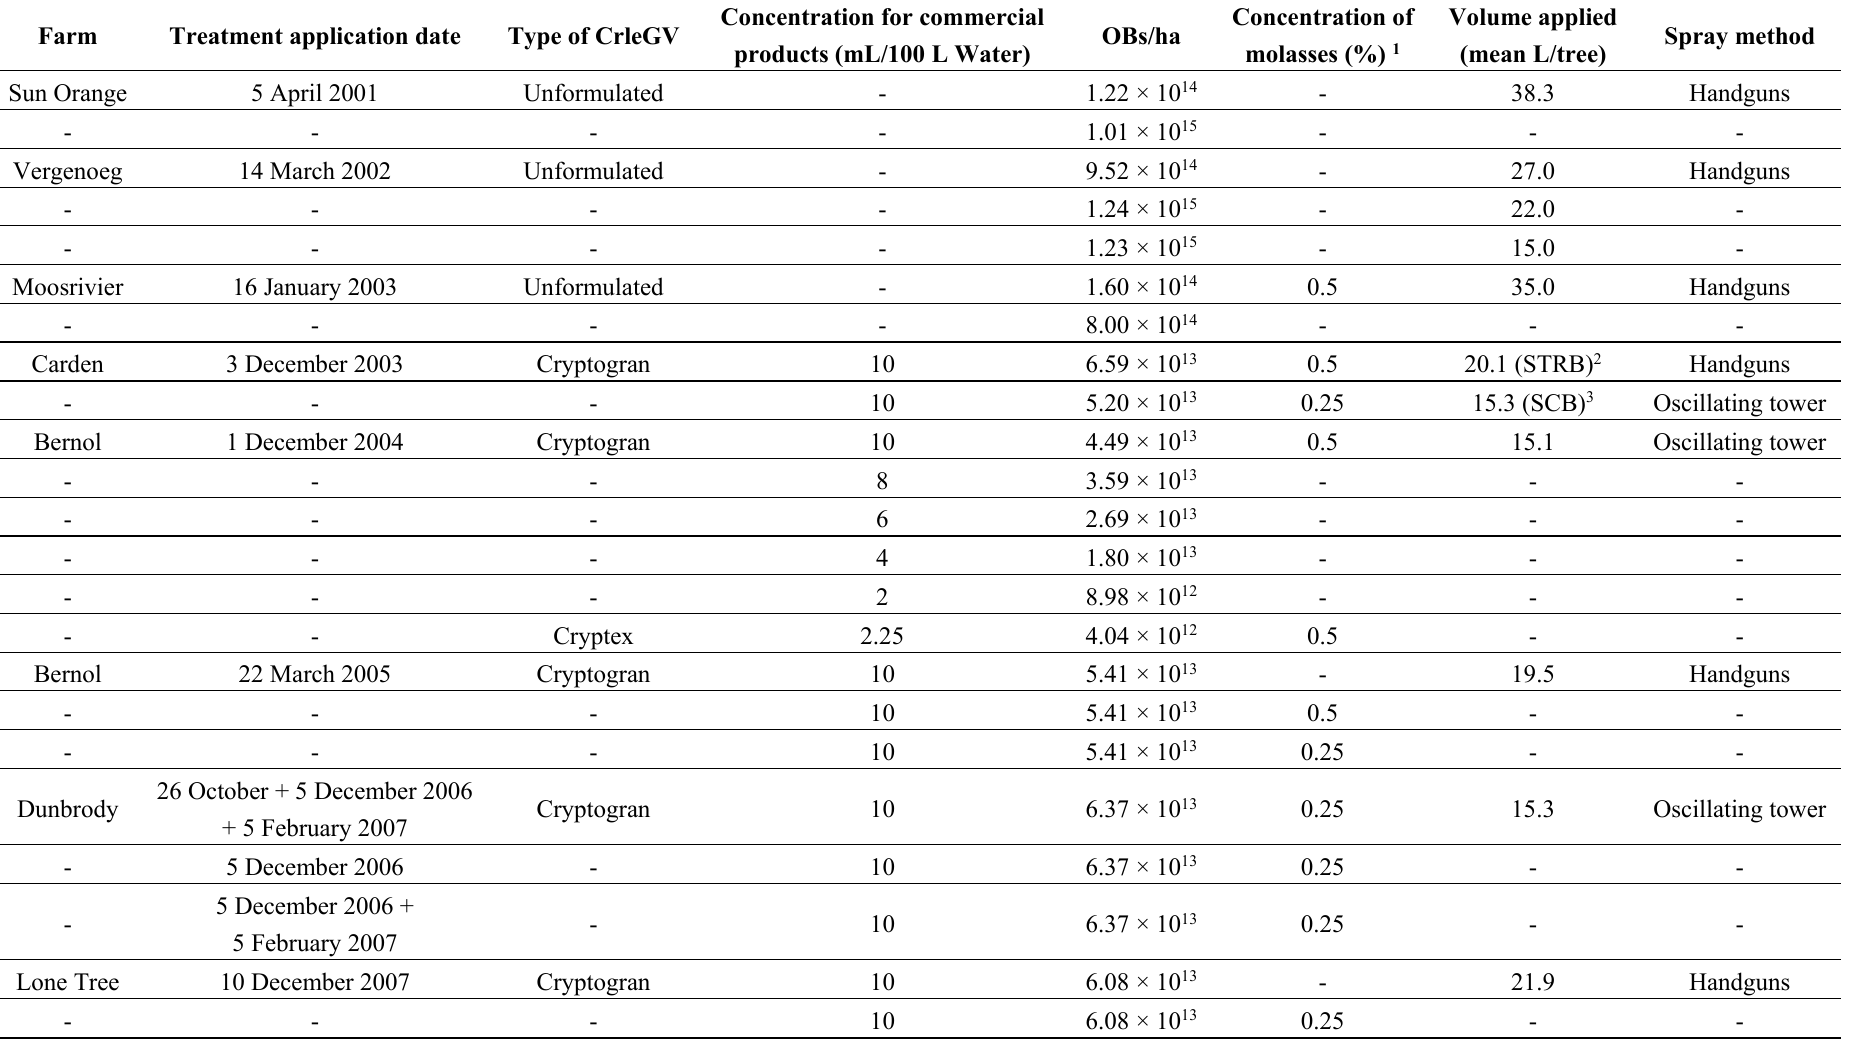
Table 3. CrleGV application details in field trials conducted against T. leucotreta in citrus